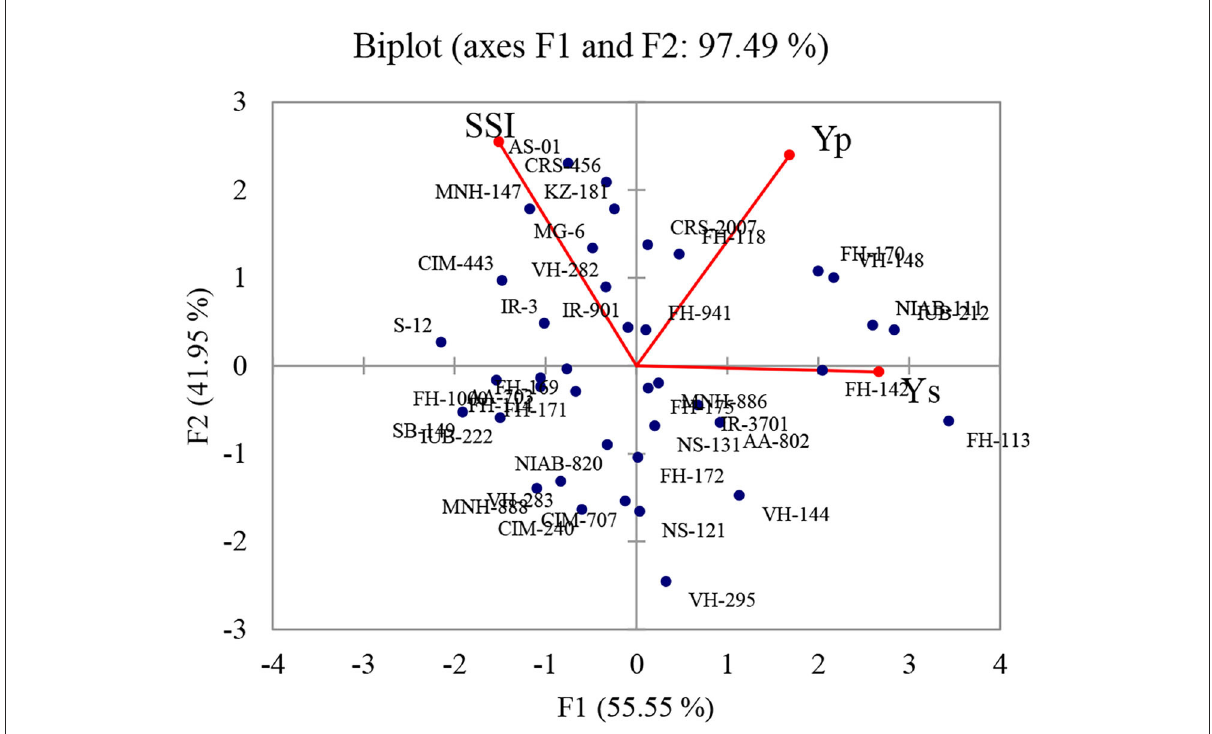
FIGURE1 Biplot for water deficit tolerance in seed cotton yield and stress susceptibility index in 40 diverse cotton genotypes based on first two components. Seed cotton yield under normal (Yp), seed cotton yield under drought (Ys), and stress susceptibility index (SSI).